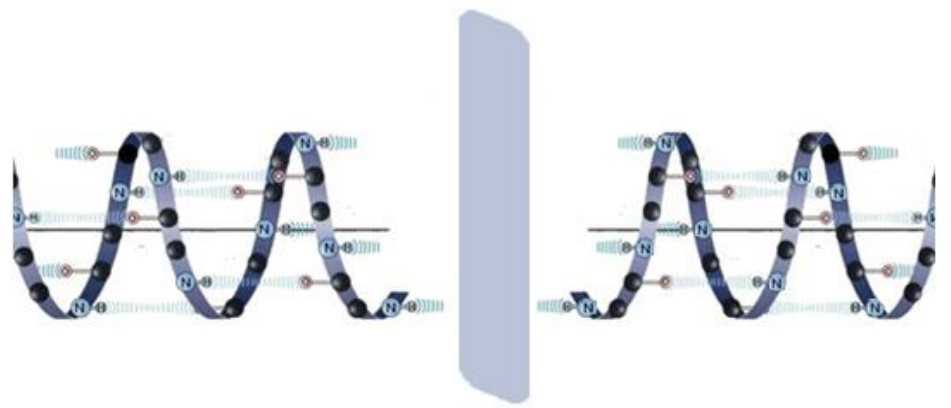
Figure 6. Natural system ( left ) and Mirror-image system ( right ).